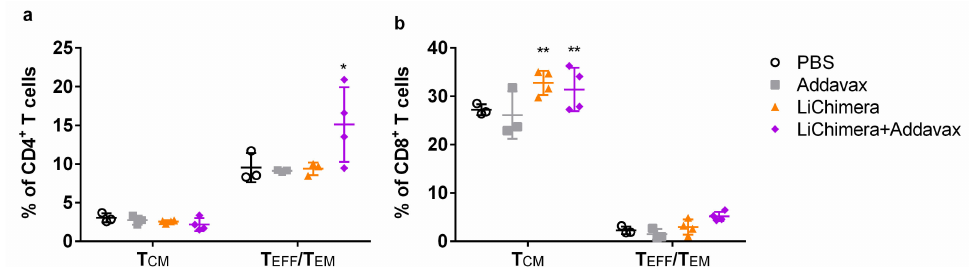
Figure 8. Generation of memory T cell subsets following vaccination with the LiChimera. The BALB / c mice were vaccinated twice intramuscularly with LiChimera alone or adjuvanted with Addavax. The control groups received PBS or Addavax. Two weeks post boosting, spleen cells were isolated and splenocytes were stimulated in vitro with LiChimera for 12 h. The percentages of the LiChimera-specific T CM and T EFF / EM ( a ) CD4 + and ( b ) CD8 + T cells were assessed by flow cytometry. Data are expressed as means ± s.d. of 3–4 mice per group are shown. Significant differences between groups are indicated with asterisks measured by one-way ANOVA and Tukey’s multiple comparison tests. * p < 0.05 and ** p <